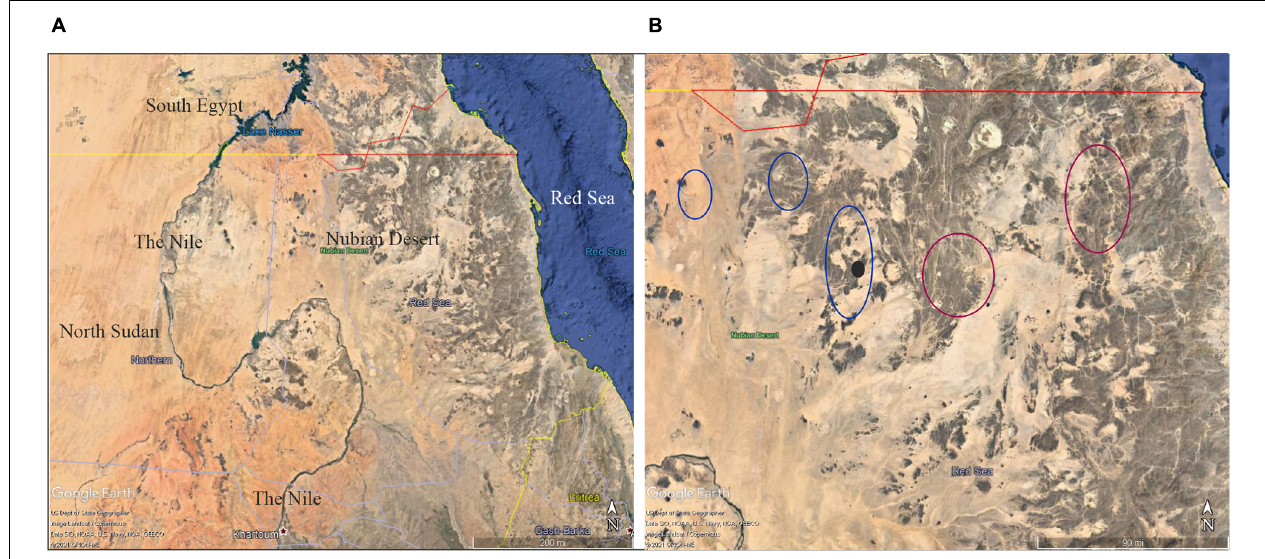
indicate previously unreported locations described by local travelers; the black circle indicates the location of the population sampled in this